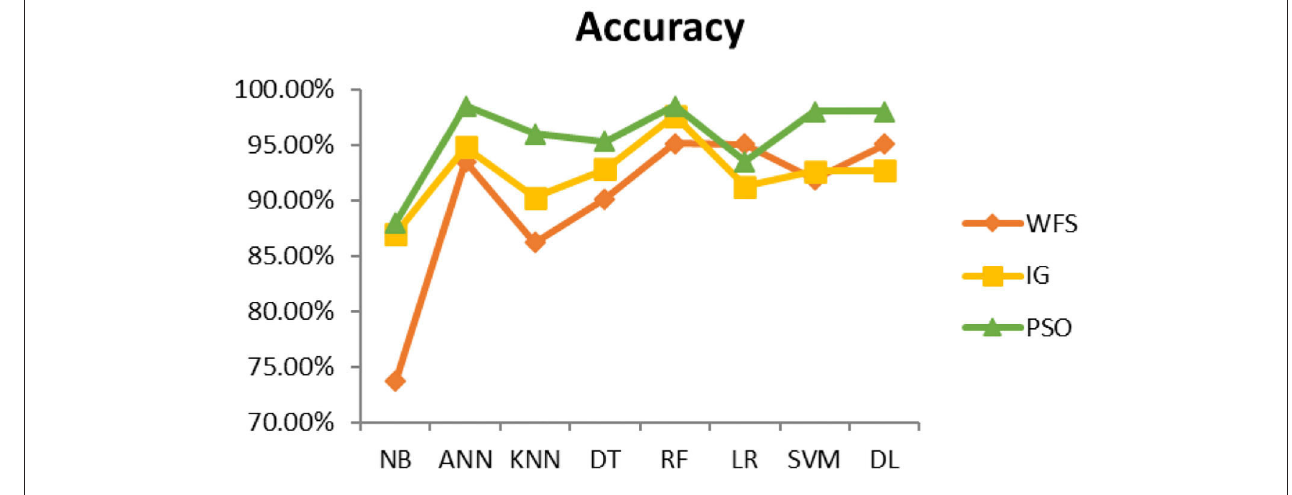
FIGURE 9 | Hepatitis diagnosis accuracy (dataset 1).